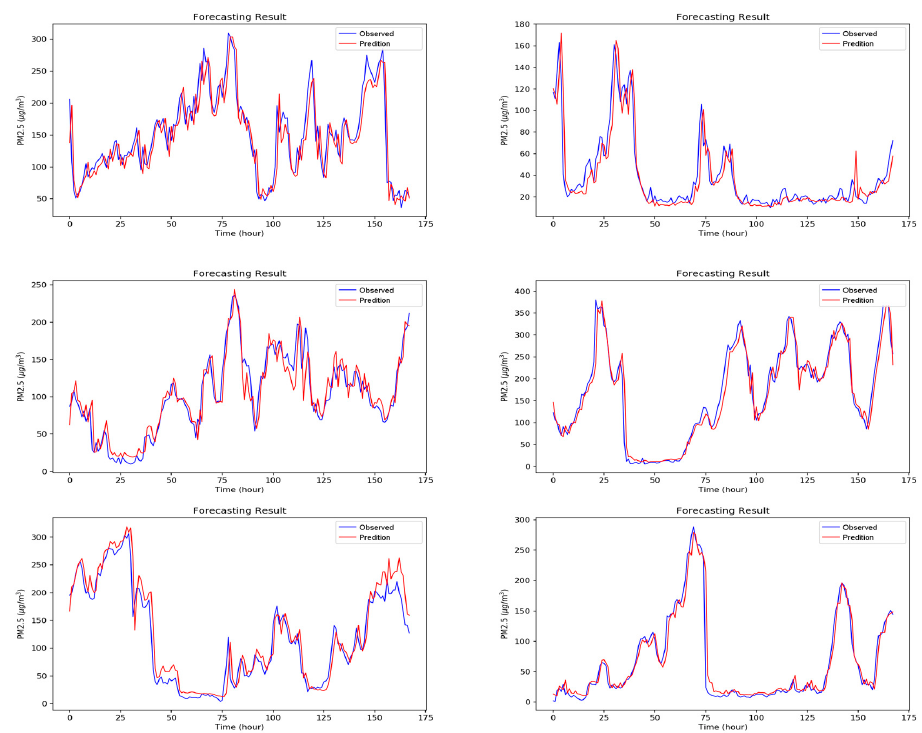
Figure A7. The forecasting results of the proposed APNet.